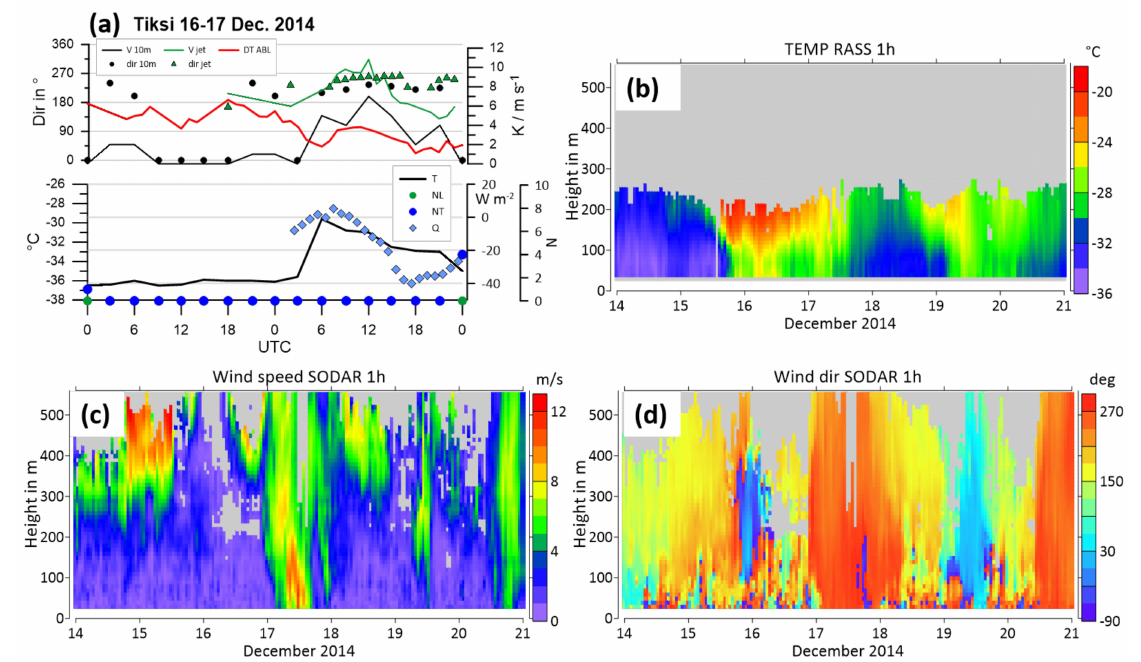
Figure 8. ( a ) Observations for 16 and 17 December 2014. Lower panel: time series of 1-hourly measurements of net radiation (Q, light blue diamonds), and 3-hourly measurements of 2 m-temperature (T) as well as observations of cloudiness in 1/10 (total NT, blue dots, and low clouds, green dots); upper panel: 10 m-wind speed (black line) and direction (black dots), jet speed (green line) and direction (green triangles), and temperature difference between 200 and 40 m (red line, scale as for wind speed). ( b )–( d ) Time-height cross-sections from SODAR/RASS data of the ( b ) temperature, ( c ) wind speed, and ( d ) wind direction from 14–21 December 2014. SODAR/RASS data are shown as pixels (not interpolated), missing data are grey. All times are in